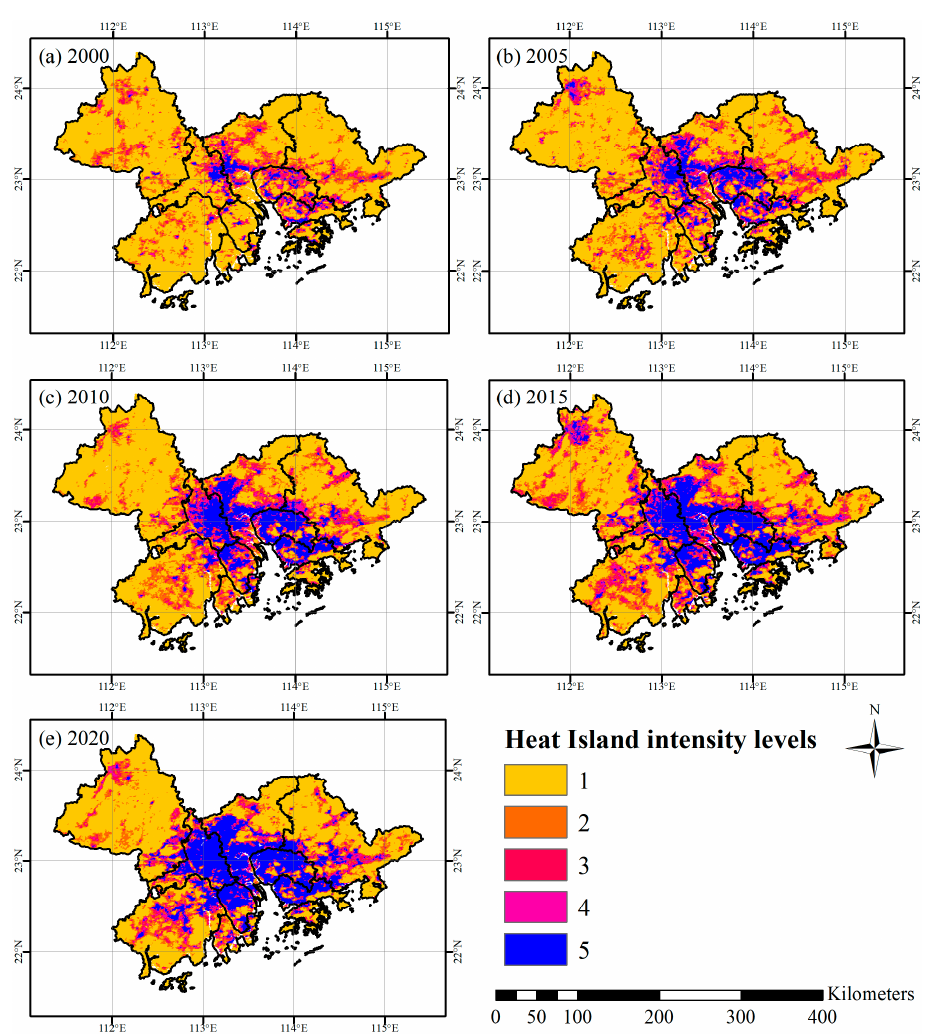
Figure 5. GBA heat Island intensity levels distribution from 2000~2020.